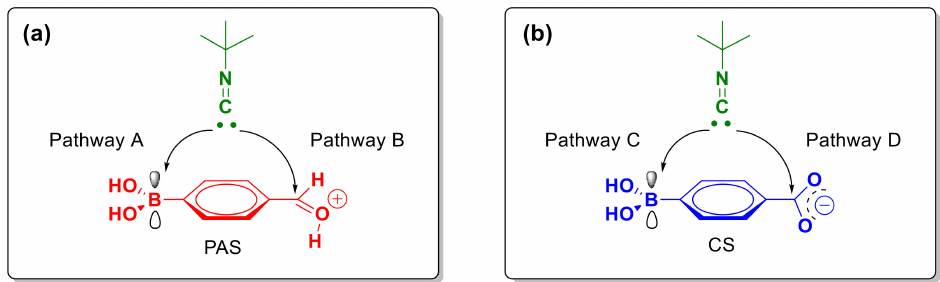
Figure 2. Postulate mechanistic model of P-3CR that involves ( a ) formylphenyl Boronic Acid (PAS); ( b ) Boronobenzoic Acid (CS).